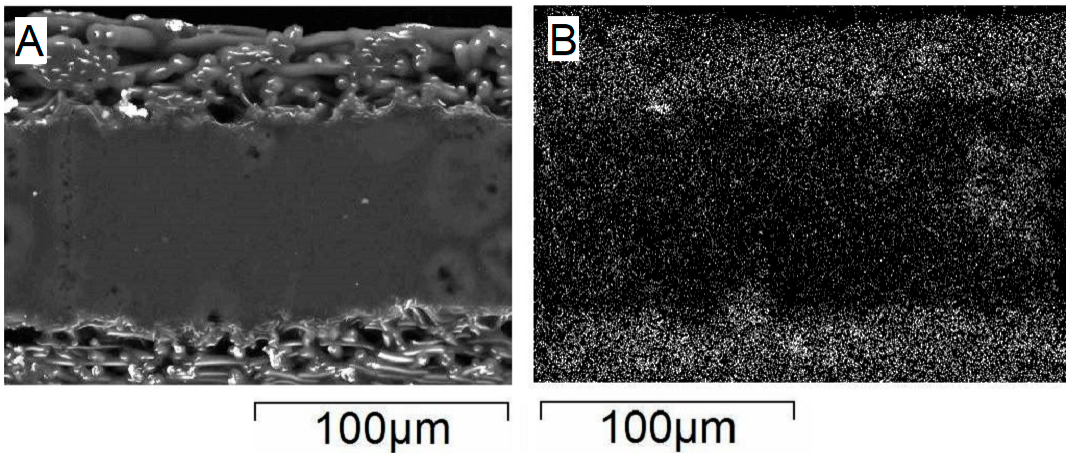
Figure 1. SEM image of the cross-section ( A ) and EDX sulfur map (distribution of [DBS] − anions) ( B ) of a PPy-gelatin actuator.